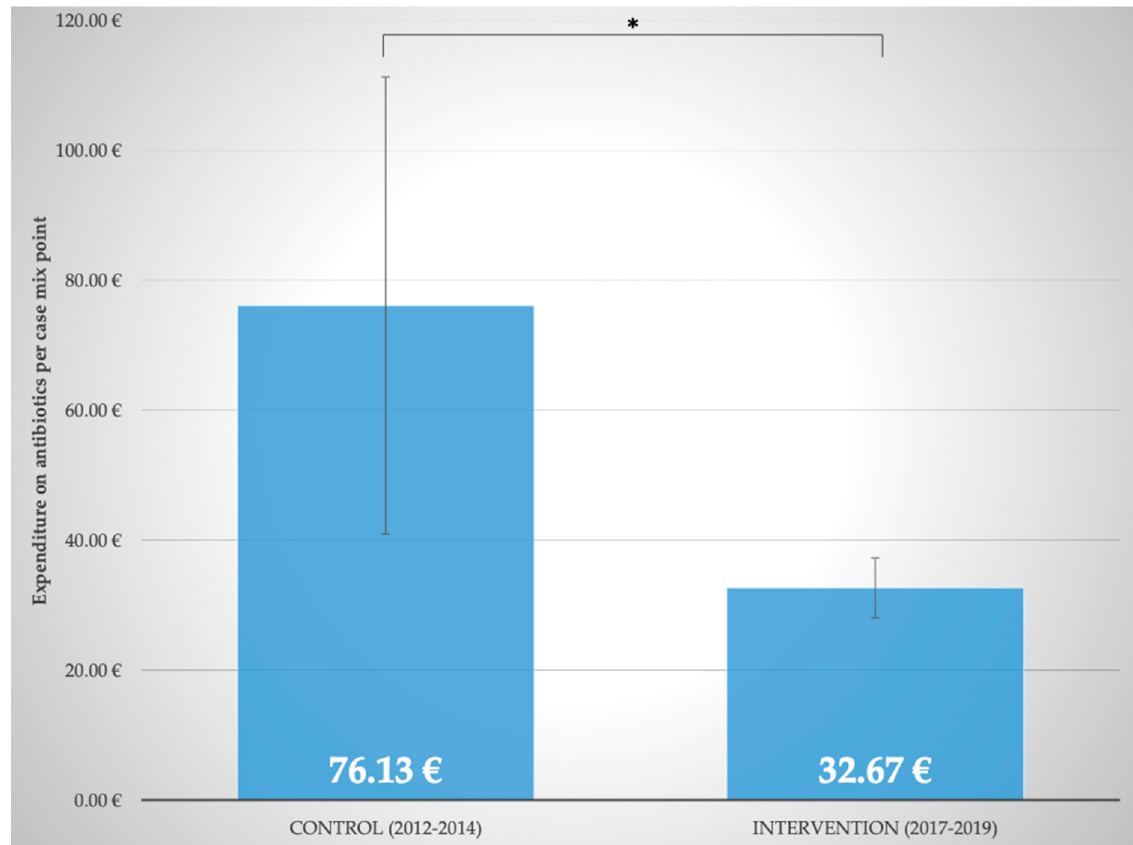
Figure 6. Expenditure on antibiotics per case mix point (€) in the control (2012–2014) and intervention group (2017–2019); * p = 0.032